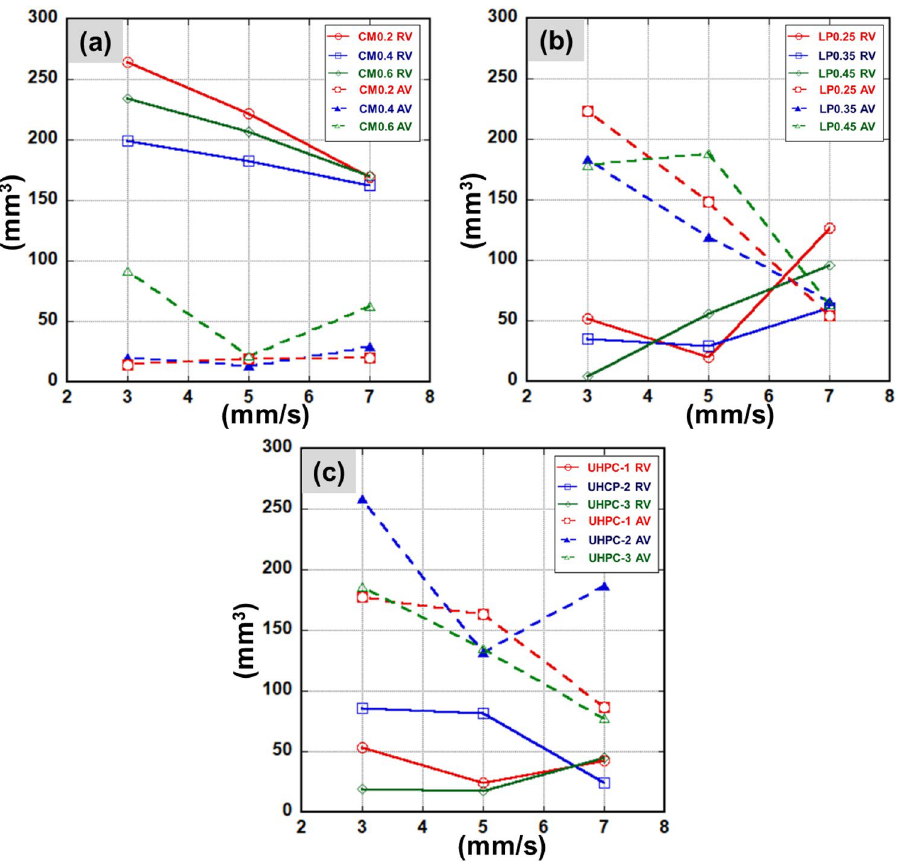
8. Removal volume (RV) and Additional volume (AV) of laser scabbling samples: ( a ) CM series, ( b ) LP series, ( c ) UHPC